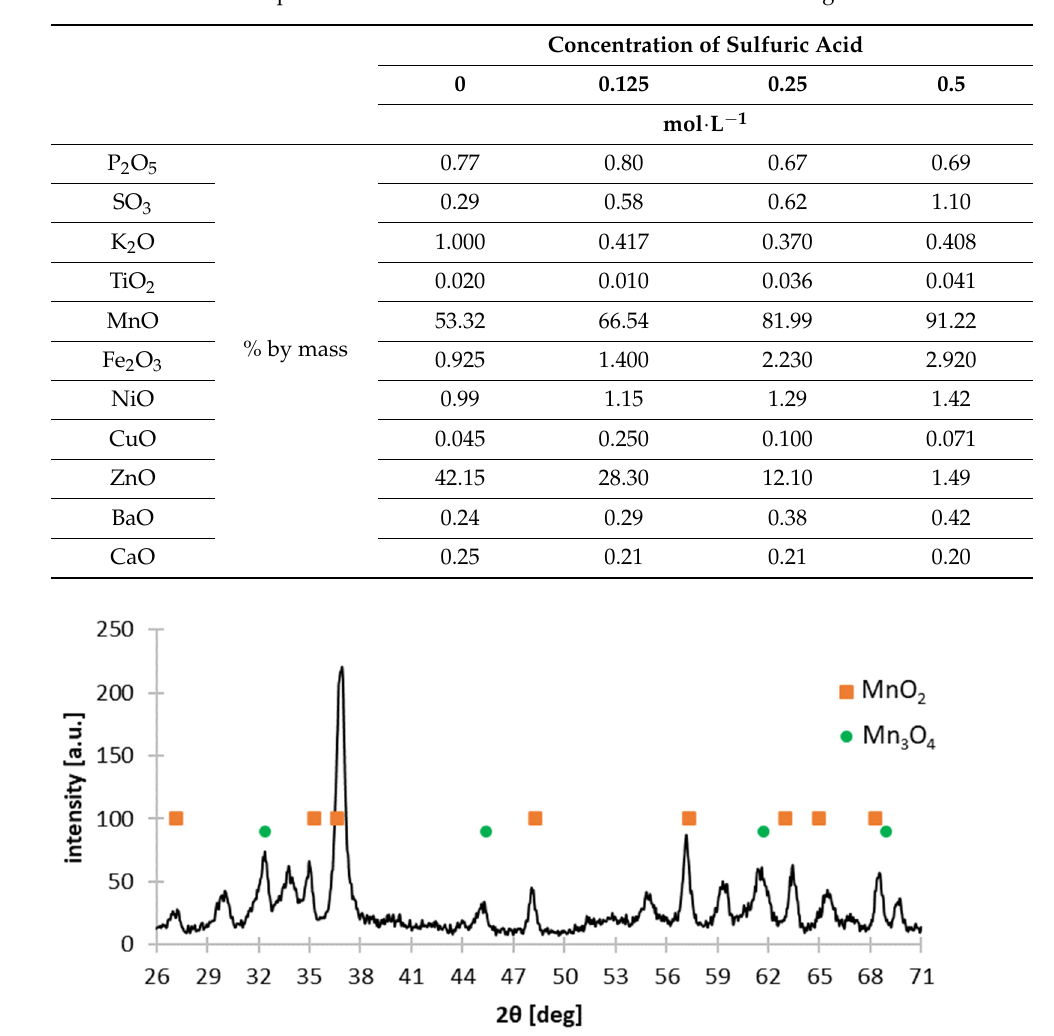
Figure 7. X-ray diffraction pattern of solid residue as a result of selective leaching of black mass in 0.25 mol · L − 1 sulfuric acid.